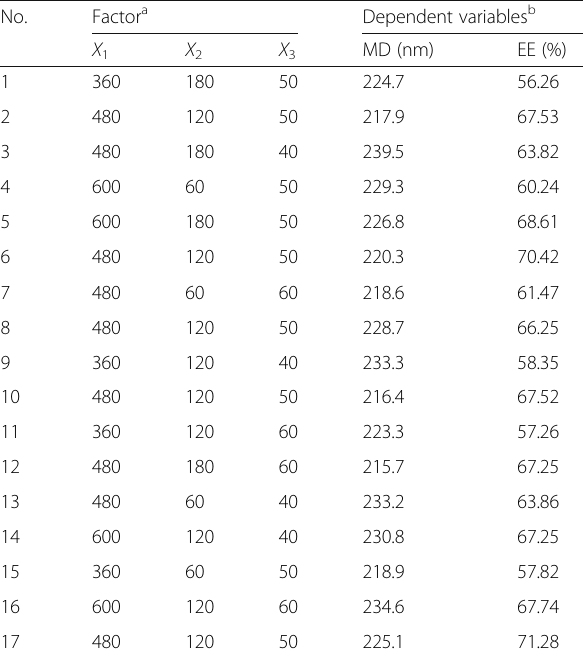
Table 2 Parameter optimization by response surface methodology